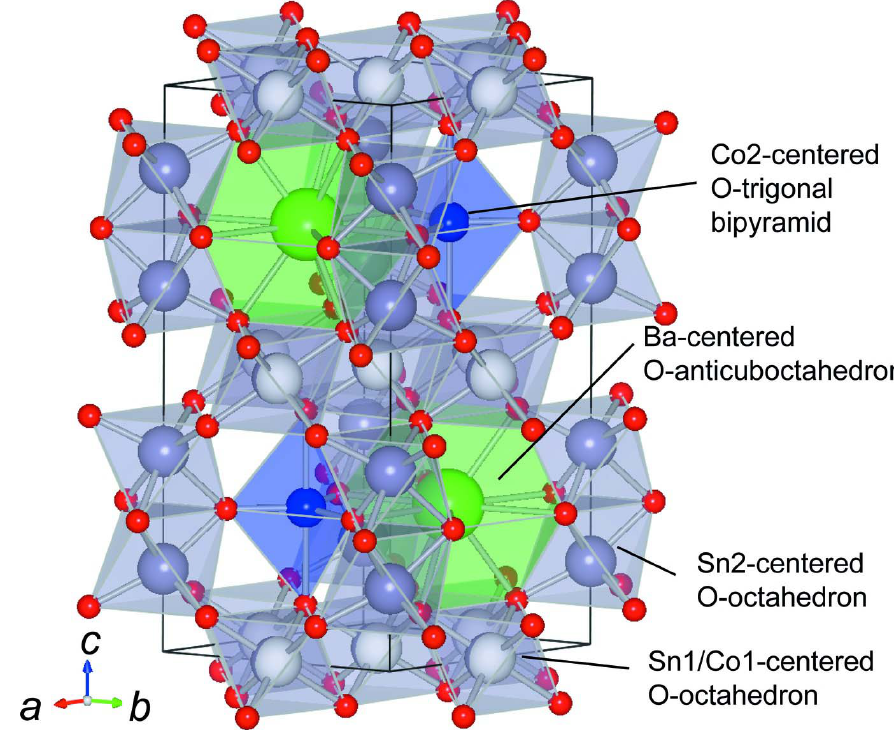
Structure of BaCo